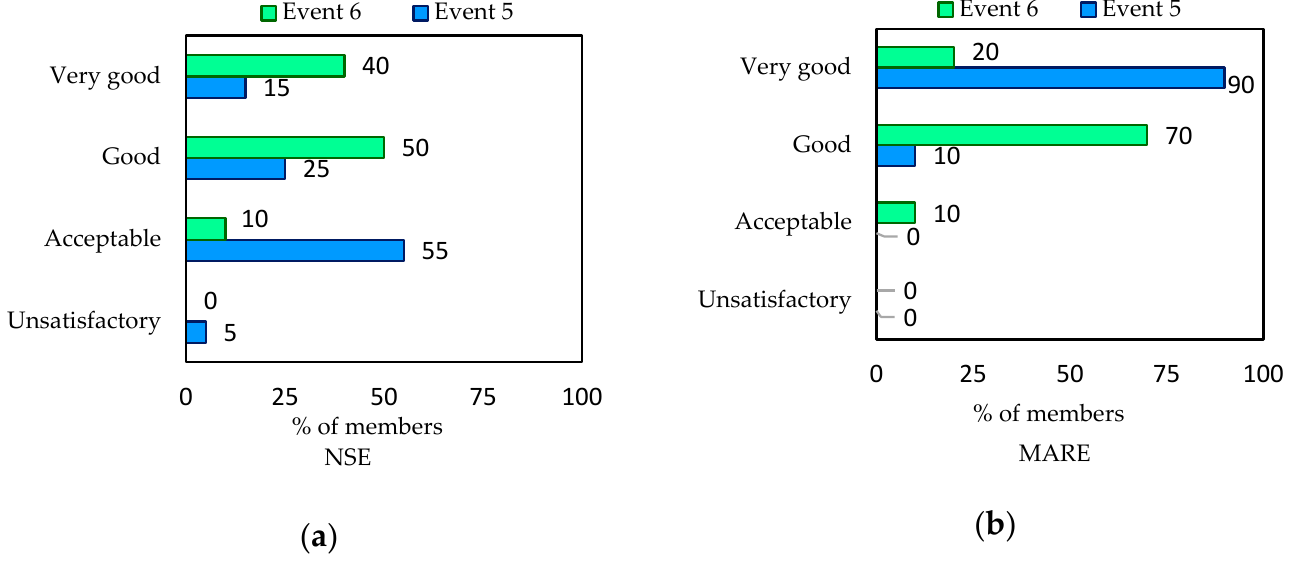
Figure 11. Model’s performance distribution over the members of ensemble reservoir inflow at the validation stage based on ( a ) NSE and ( b ) MARE criteria .